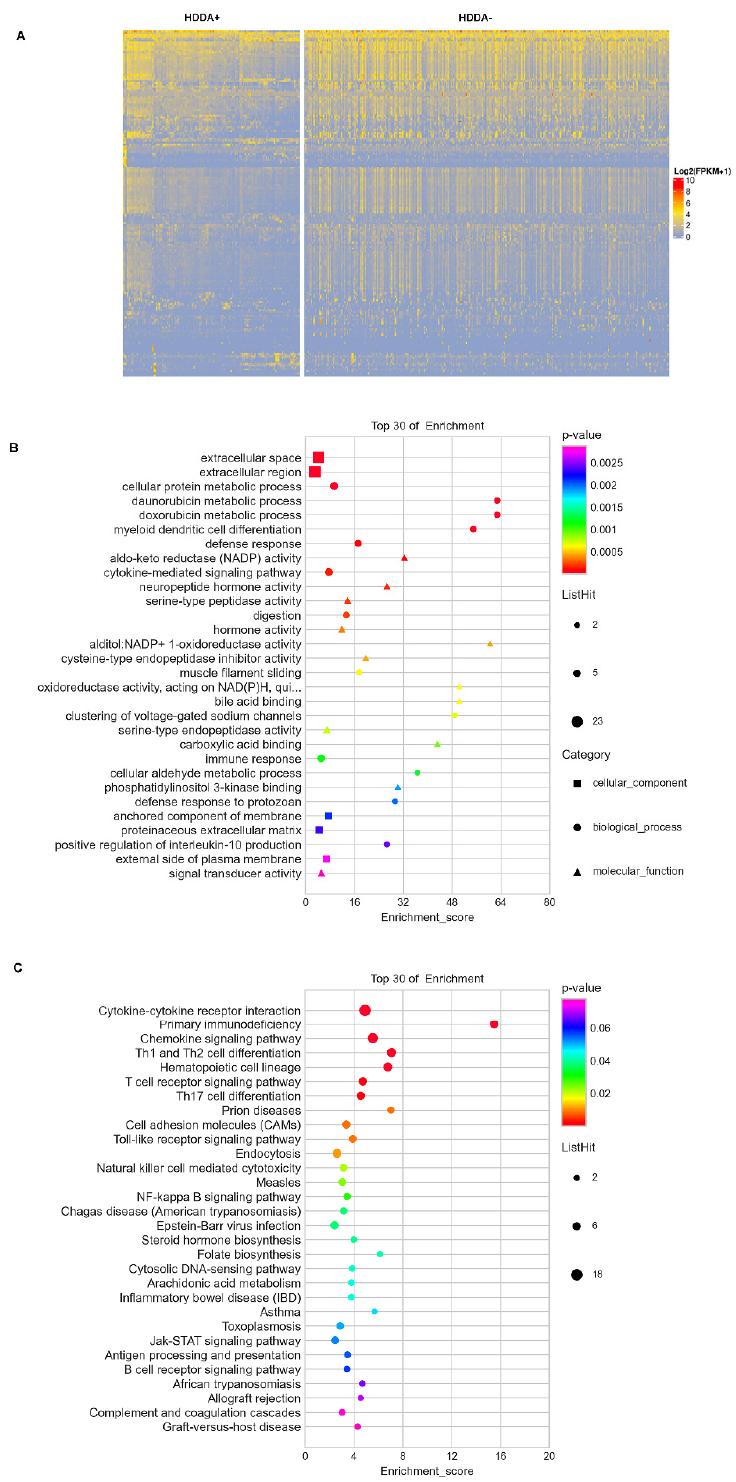
Figure 4. Differentially expressed genes (DEGs) and GO term/pathway enrichments in HDDA TC tumors. ( A ) The heatmap showing DEGs between tumors with and without HDDA based on the Table S3. There are 180 DEGs in tumors with HDDA (DNAmaa and DNAmad) compared to non-HDDA tumors, among which were 134 down- and 46 up-regulated genes, respectively. Scale: 0 to 10. ( B ) The enrichment of the GO terms in HDDA tumors. Shown are top 30 enriched GO terms including cellular components, biological processes and molecular function. ( C ) The KEGG analyses for the pathway enrichments in HDDA tumors. The top 30 enriched pathways are